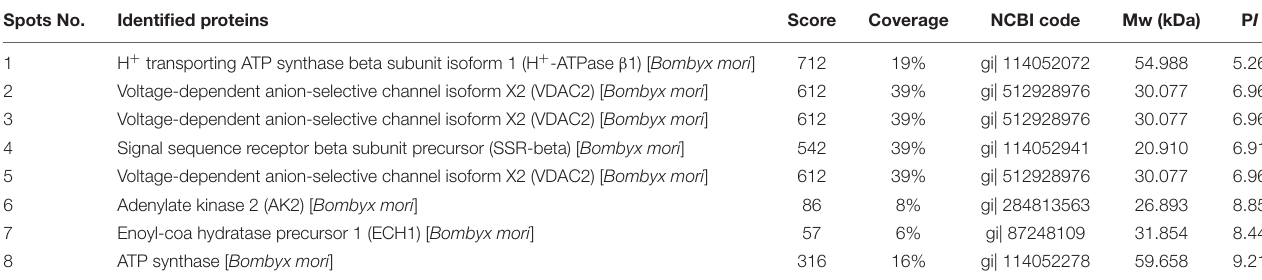
( Figure 9J ), ECH2 ( Figure 9K ), Acads ( Figure 9L ), RACK- 1 ( Figure 9N ), ETF-alpha ( Figure 9S ), SSR-beta ( Figure 9T ), and trypsin ( Figure 9W ), were upregulated significantly in the P50 strain following BmNPV infection at 24 hpi. The